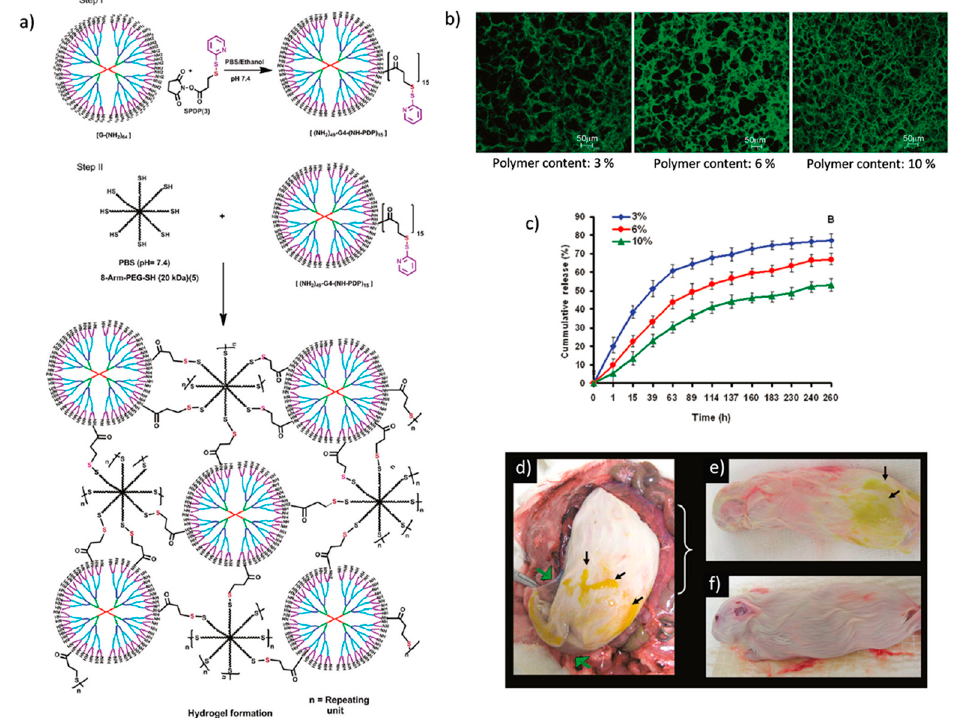
Figure 10. ( a ) Disulfide formation for crosslinking; ( b ) 3% hydrogel, 6% hydrogel and 10% hydrogel show the crosslinking network changes; ( c ) cumulative release profiles of hydrogels; degraded hydrogel on fetal membrane; ( d , e ) no signs of transfer inside the fetal membrane; ( f ) adapted with permission from [31], Copyright © 2011 American Chemical Society.